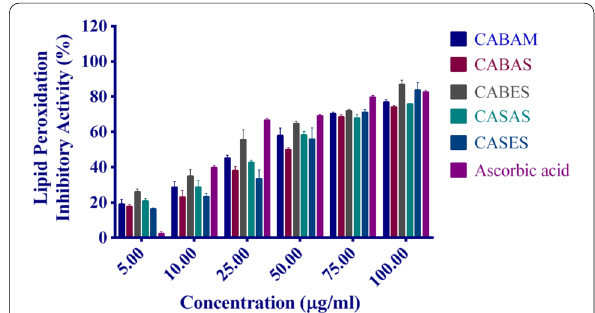
Fig. 3 Lipid peroxidation inhibitory activity of C. albidum extracts. Values represent mean standard deviation ( n 3). CABAM C. ± = albidum bark acetone extract obtained by maceration for 30 min, CABAS C. albidum bark acetone extract obtained by sonication for 30 min, CABES C. albidum bark ethanol extract obtained by sonication for 30 min, CASAS C. albidum seeds acetone extract obtained by sonication for 30 min, CASES C. albidum seeds ethanol extract obtained by sonication for 30 min, Asc. Acid ascorbic acid